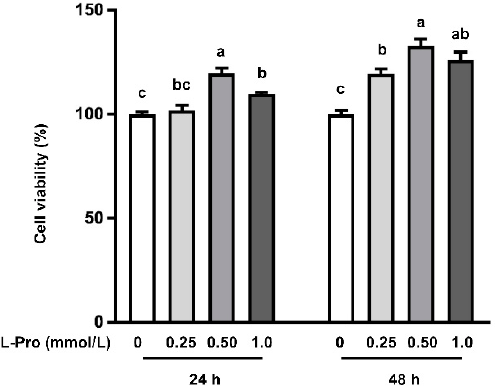
Figure 1. Effects of L-proline on the growth of pTr2 cells at 24 or 48 h. Data are expressed as the percentage of control group. Values are means ± SEMs, n = 6. Means at a time point without a common letter differ, p < 0.05. pTr2, porcine trophectoderm cell line 2.